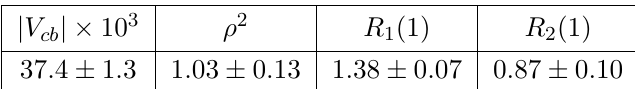
Table 1 . CLN parameters (cid:12)tted by Belle Collaboration